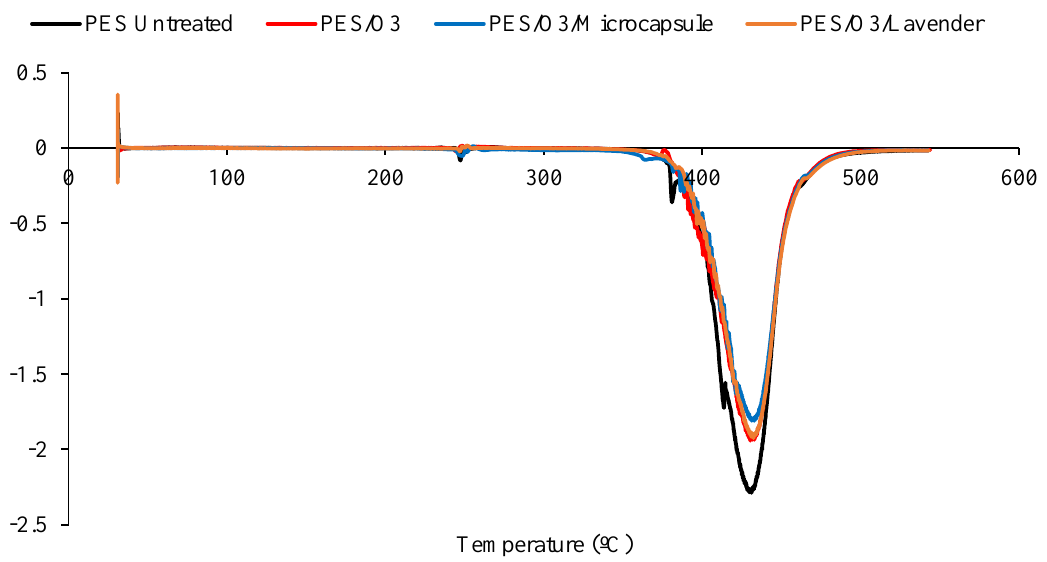
Figure 6. The DTG comparison of the untreated polyester and plasma-treated samples, impregnated with lavender essential oil or microcapsules.. Untreated polyester (black), plasma-treated polyester (red), plasma-treated polyester with microcapsules (blue), and plasma-treated polyester with the lavender essential oil (brown).